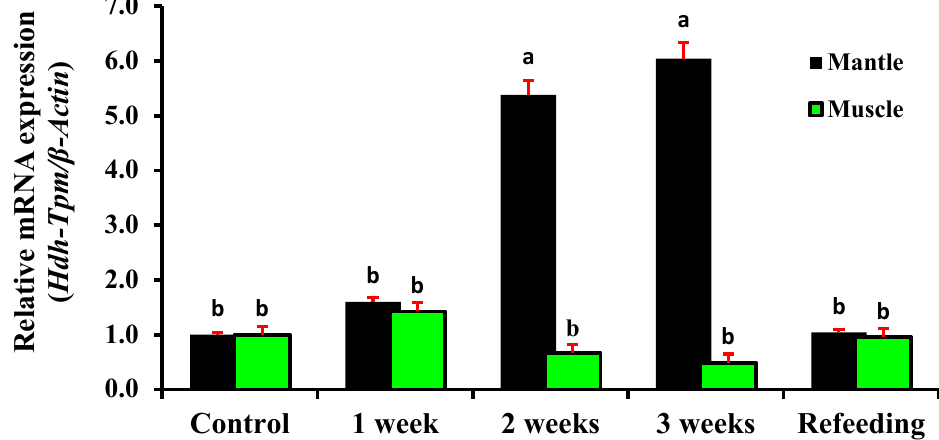
Figure 12. Expression of Hdh-TPM in the mantle and muscle of starved Pacific abalone H. discus hannai. Significantly different levels ( p < 0.05) are denoted by different letters.